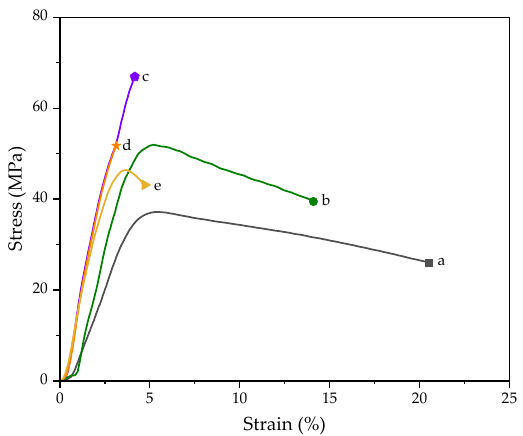
Figure 10. Tensile stress–strain curve of PLA/nHAp composite films with nHAp from different preparation steps and 1DP-nHAp at various contents (a) PLA, (b) PLA/1DP-nHAp , 2.5 (c) PLA/1DP-nHAp , (d) PLA/2DP-nHAp , and (e) PLA/1DP-nHAp 5 5 10 Table 2. Mechanical properties of PLA/nHAp composite films with nHAp from different steps of preparation and 1DP − nHAp at various contents.